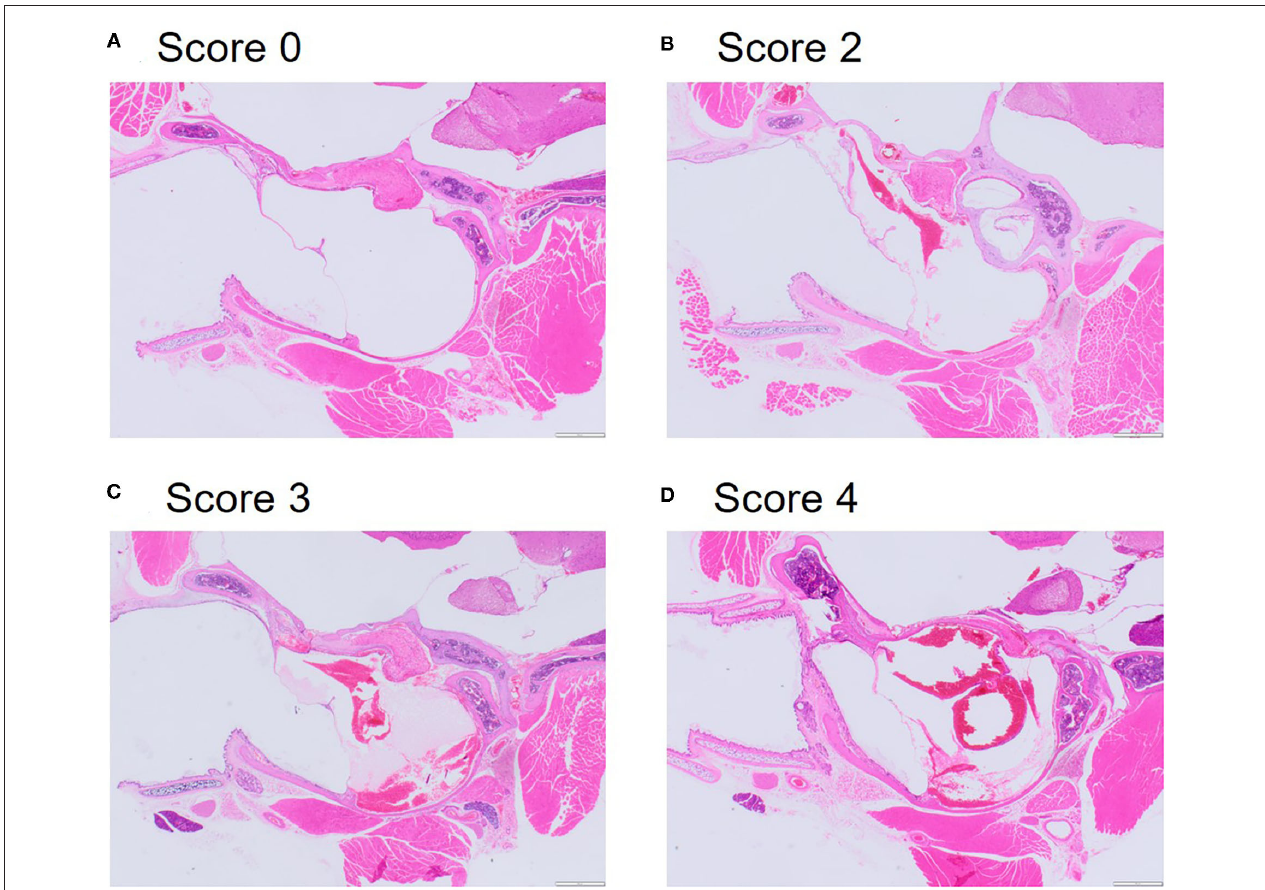
FIGURE 5 | Representative microphotographs of scores for congestion and hemorrhage in the middle inner ear. (A) Score 0 represents absence of congestion and hemorrhage from non-decompressed control mouse. (B) Score 2 represents mild congestion and hemorrhage. (C) Score 3 represents moderate congestion and hemorrhage. (D) Score 4 represents marked congestion and hemorrhage. Haematoxylin and Eosin (HE)